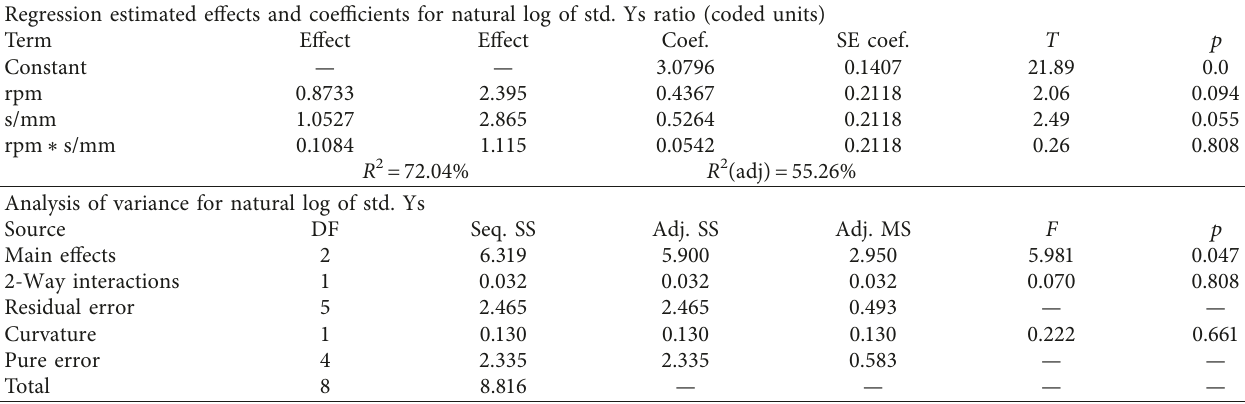
Table 3: Results of yield strength analysis of